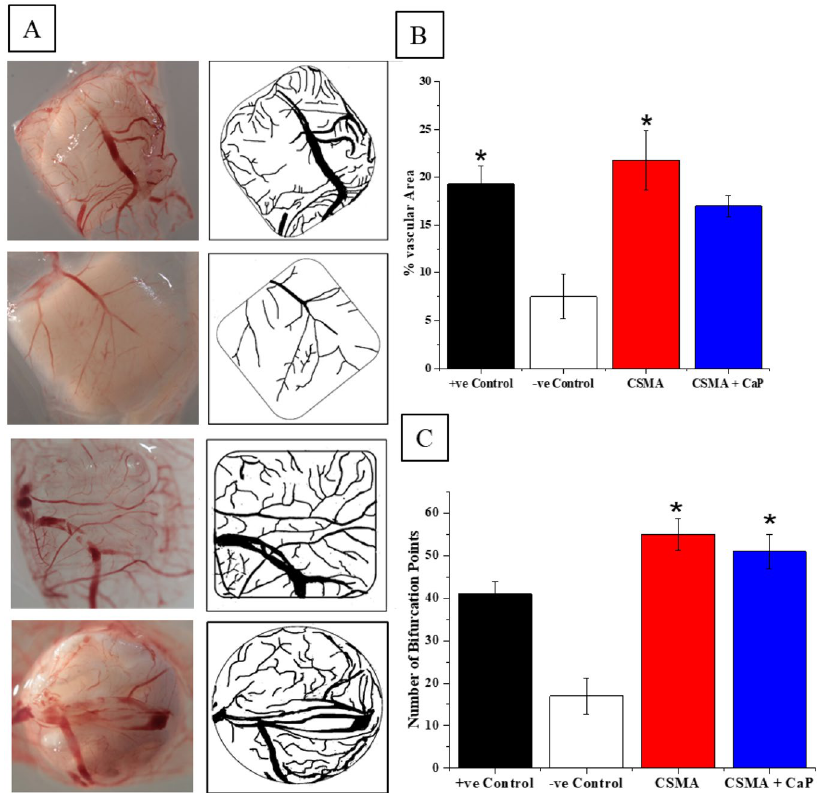
Figure 9. A representative stereomicroscope images of VEGF positive control, PBS negative control, CSMA and CSMA + CaP. B, percentage of vascular area calculated for each sample followed by C, number of bifurcation points, the significantly higher values have been marked with an asterisk